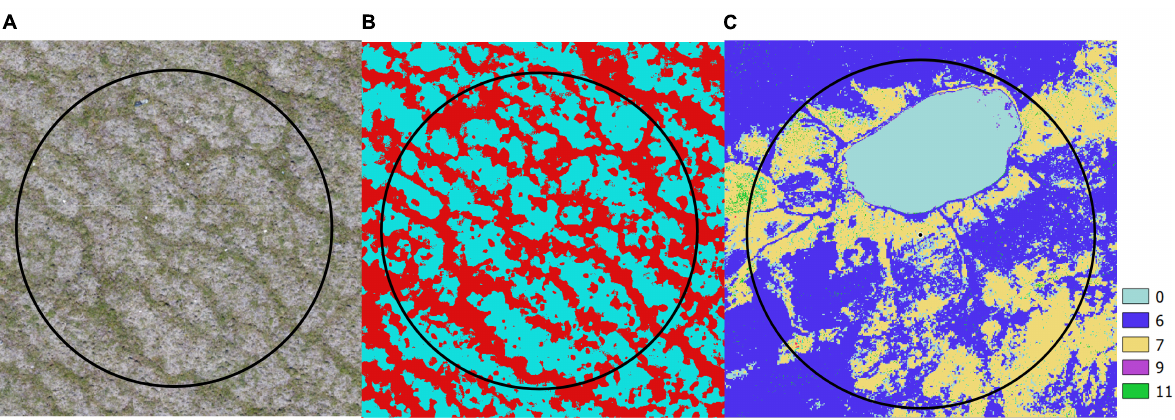
All climate variables are positively related to axis 1 with high scores. RDA1 scores of constraining variables are 0.9426 and 0.9327 (MAT) and 0.8948 and 0.9083 (MAP) for moss/soil